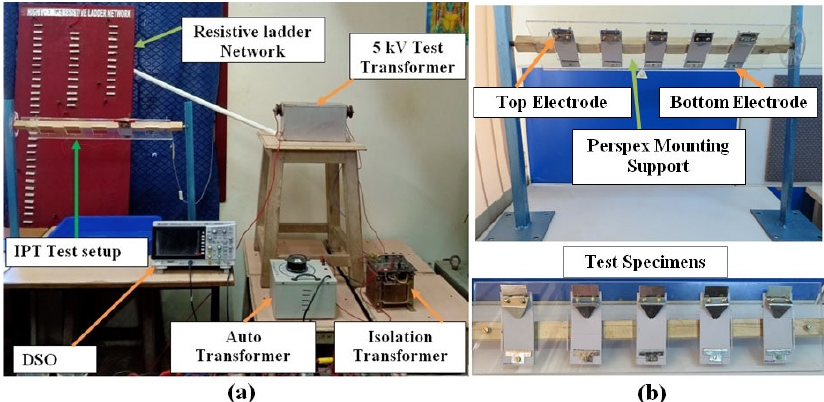
Figure 3. Photograph of the experimental setup and mounting support: ( a ) Experimental set up, ( b ) mounting support.